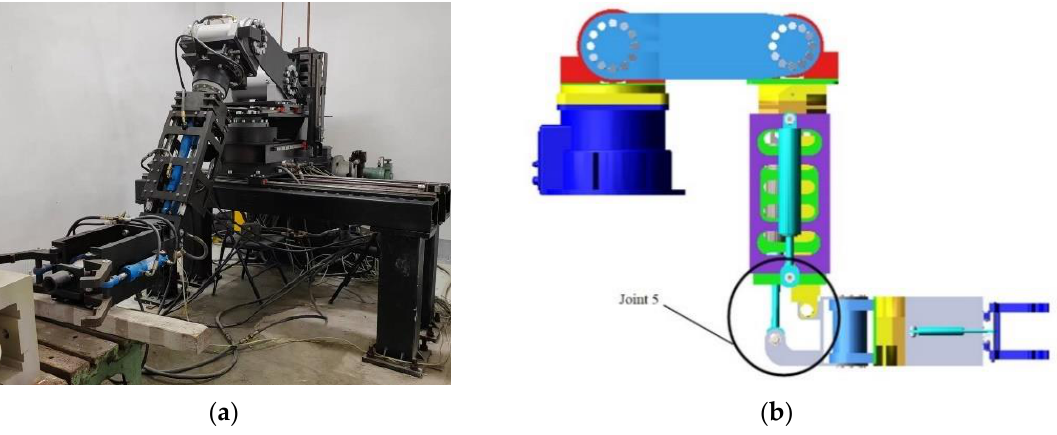
Figure 5. The shield machine tool-changing robot. ( a ) Real robot. ( b ) 3D simulation